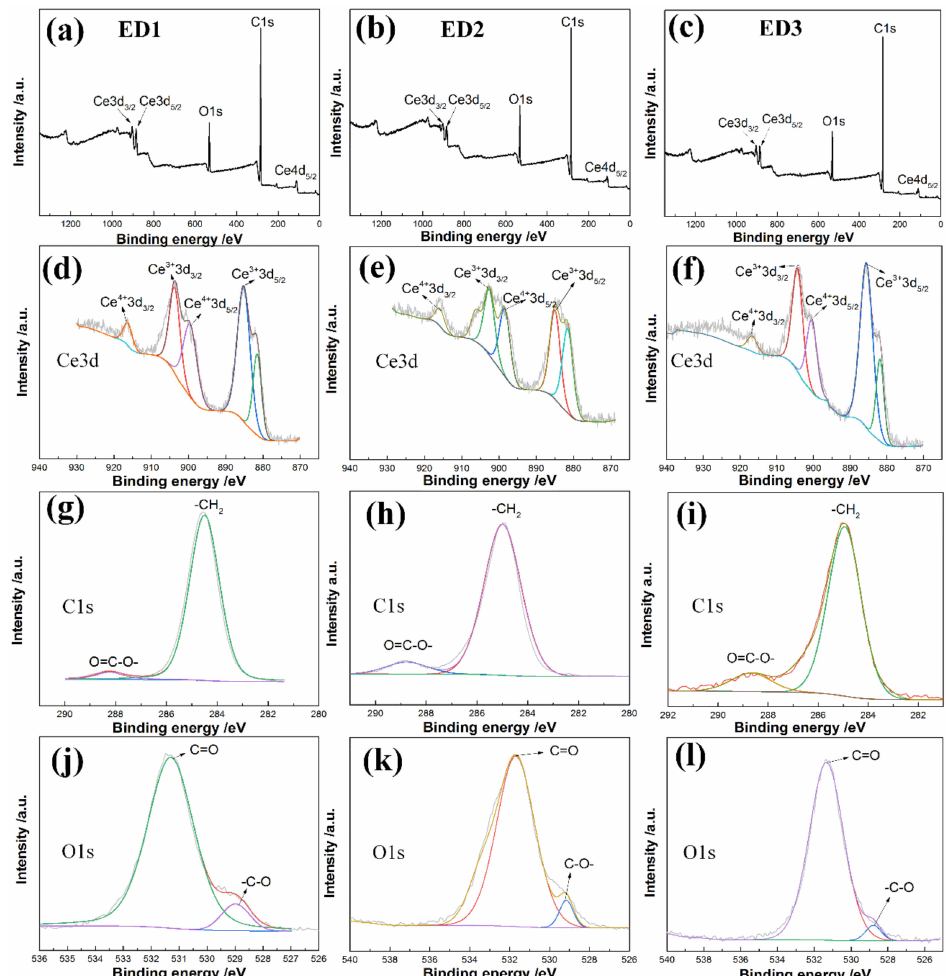
Figure 4. The XPS results of the electrodeposited